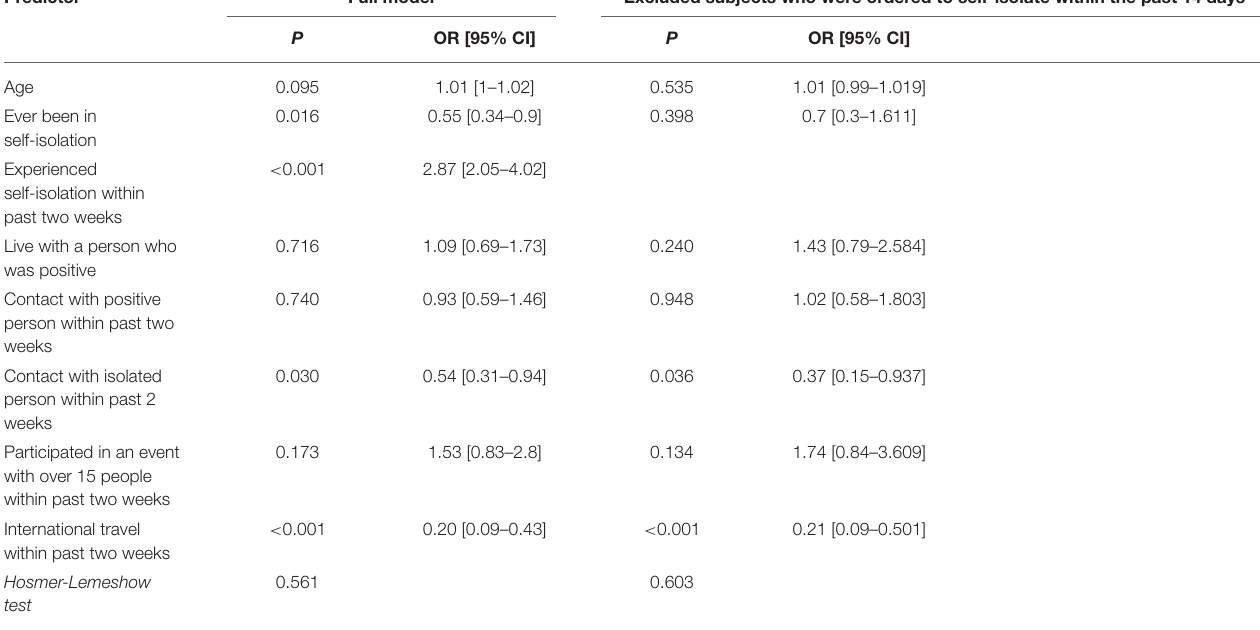
TABLE 3 | Exposures and risks for antigen positive test results, logistic regression.